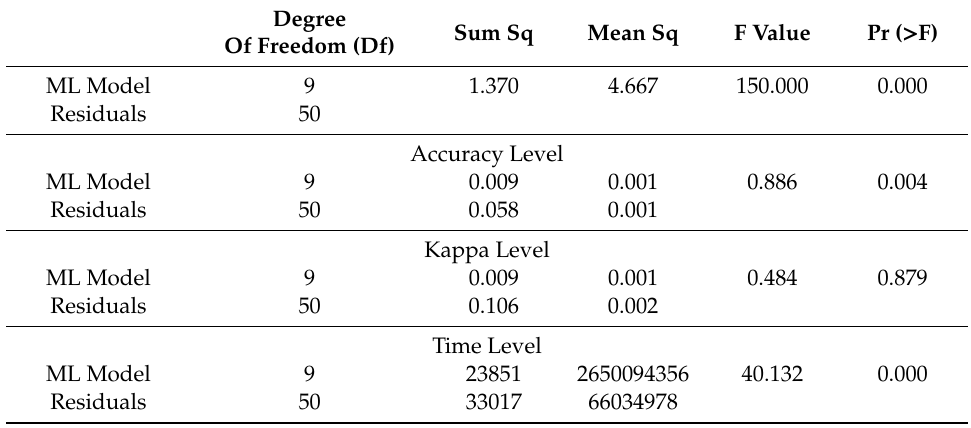
Table 4. Analysis of variance with repeated measures ANOVA of three performance variables (accuracy, kappa and processing